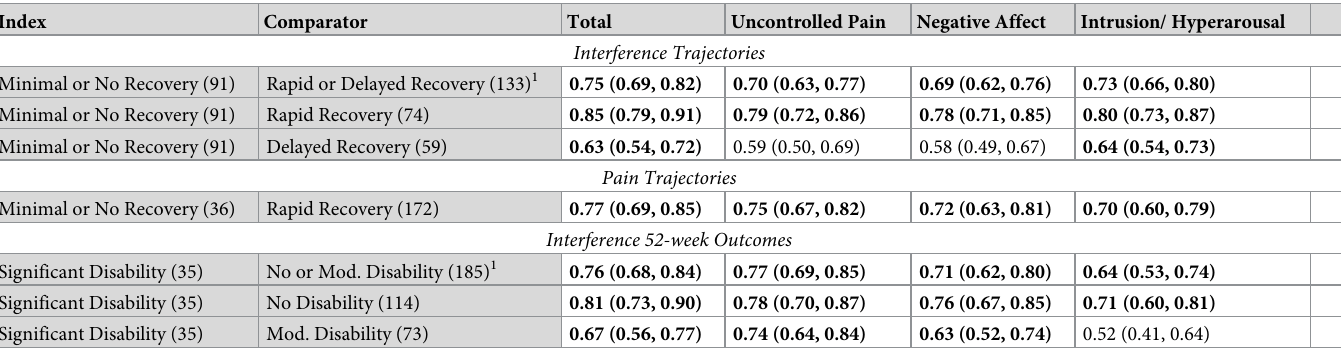
Table 4. Area under the receiver operating characteristic curve (AUC) for all relevant comparisons as indicators of discriminative